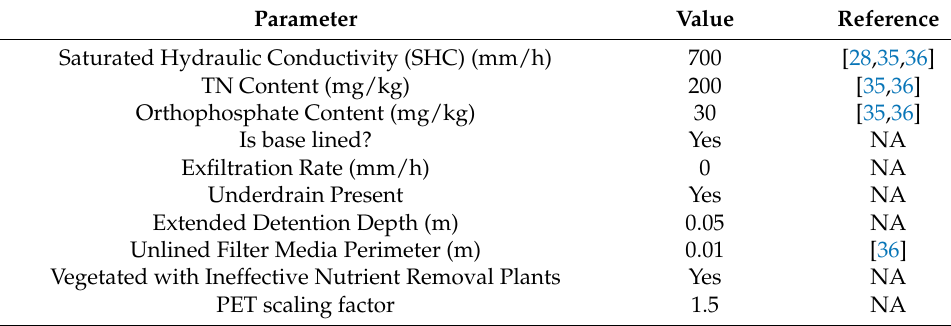
Table 6. Soil characteristics for the green roof in MUSIC’s bioretention node